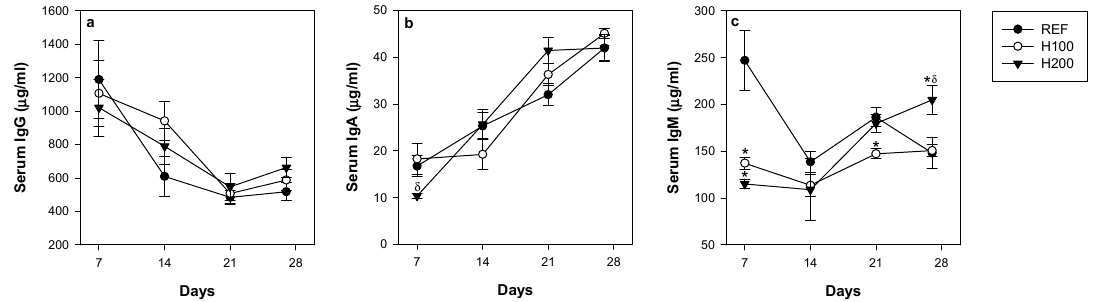
Figure 7. Effect of hesperidin administration throughout the study on serum ( a ) IgG; ( b ) IgA; and ( c ) IgM. Data are expressed as mean ± standard error ( n = 5–6). Statistical difference: * p < 0.05 versus REF group, δ p < 0.05 versus H100 group (Mann–Whitney U test).